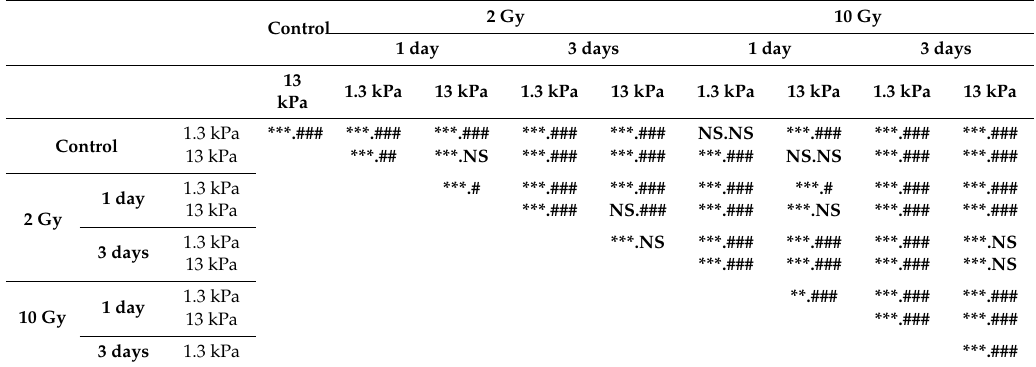
Table 2. Statistical analysis for motility data.